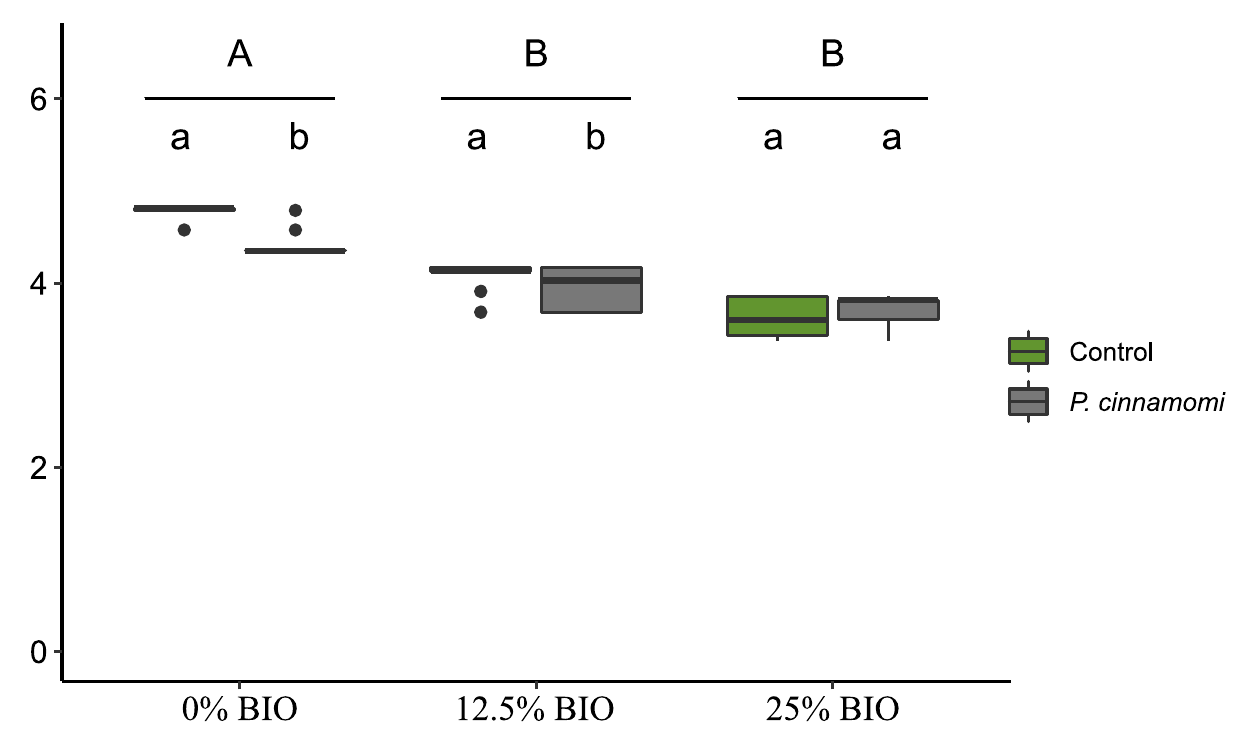
Figure 4. Boxplot of predicted values of height:diameter ratio (H/D) separated by soil treatments ( x -axis) and P. cinnamomi infection (control plants, green; infected plants, grey). Lowercase letters indicate differences between P. cinnamomi infection treatments, and capital letters indicate differences among soil treatments.